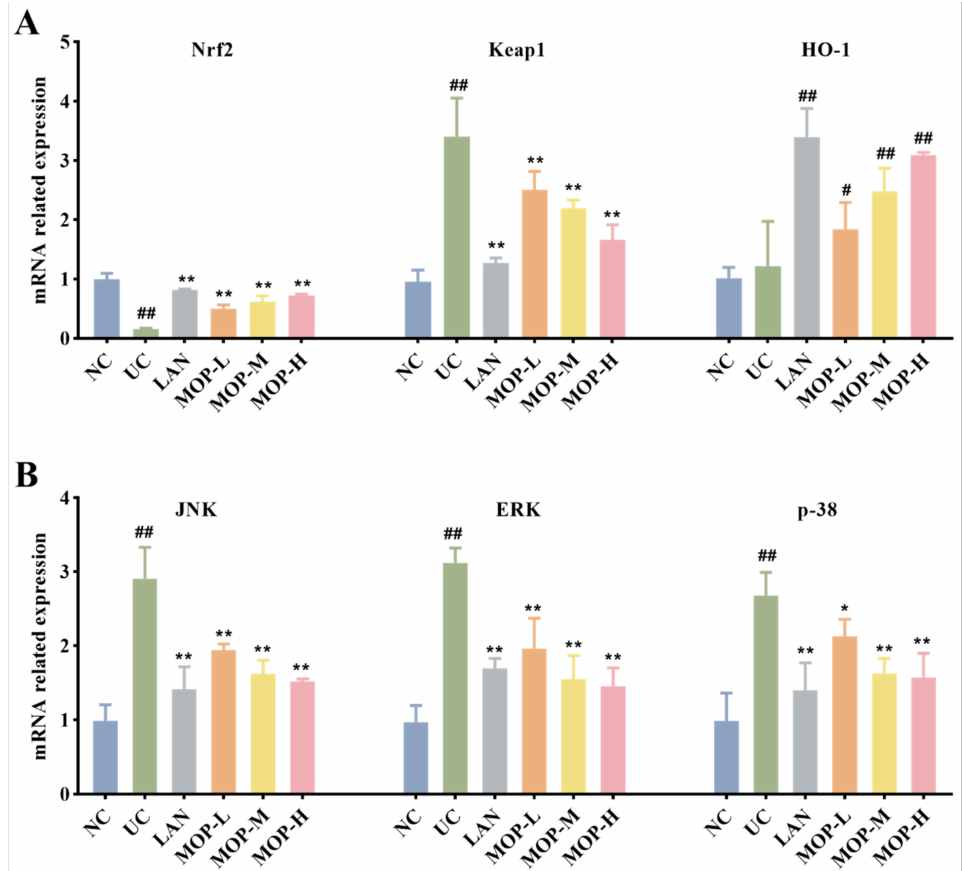
Figure 5. mRNA expression levels of Nrf2, HO-1 and Keap1 ( A ), p38, JNK and ERK ( B ) in stomach tissue of MOP pretreated ethanol-induced gastric mucosal injury. All experiments were performed in triplicate (n = 3) to determine the repeatability. # and * denotes significant differences. # p < 0.05,